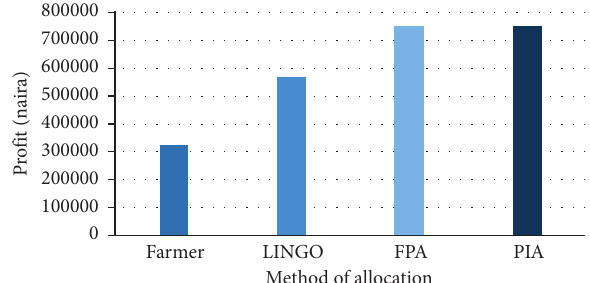
Figure 2: Chart showing profits